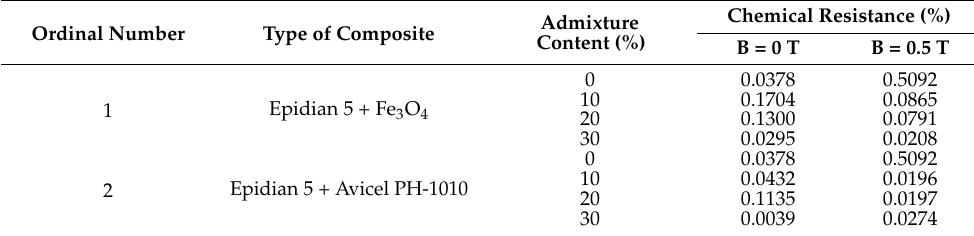
Table 18. Chemical resistance to acid (H 2 SO 4 ).